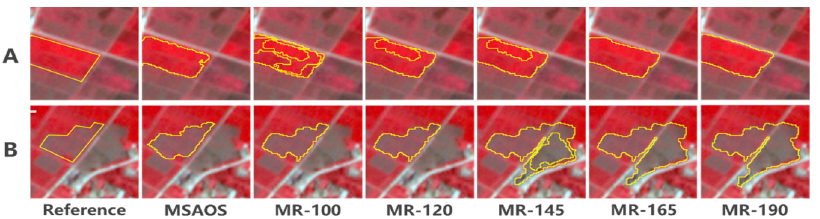
Figure 11. Detailed comparisons of the cropland parcel extraction results derived by MSAOS and MR methods with different segmentation scales. The numbers (e.g., 100) refer to the segmentation scales of the MR method.